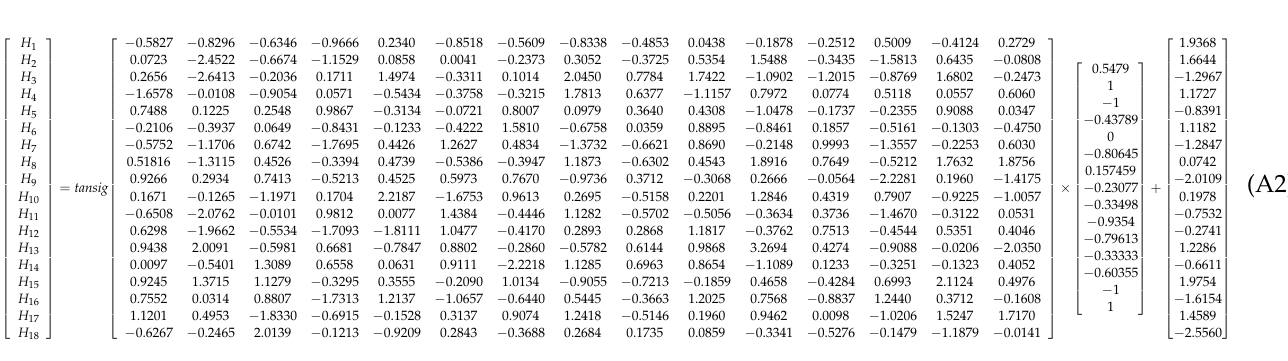
The final values of H 1 to H 18 neurons are shown in Table A1. Table A1. Values of H 1 to H 18